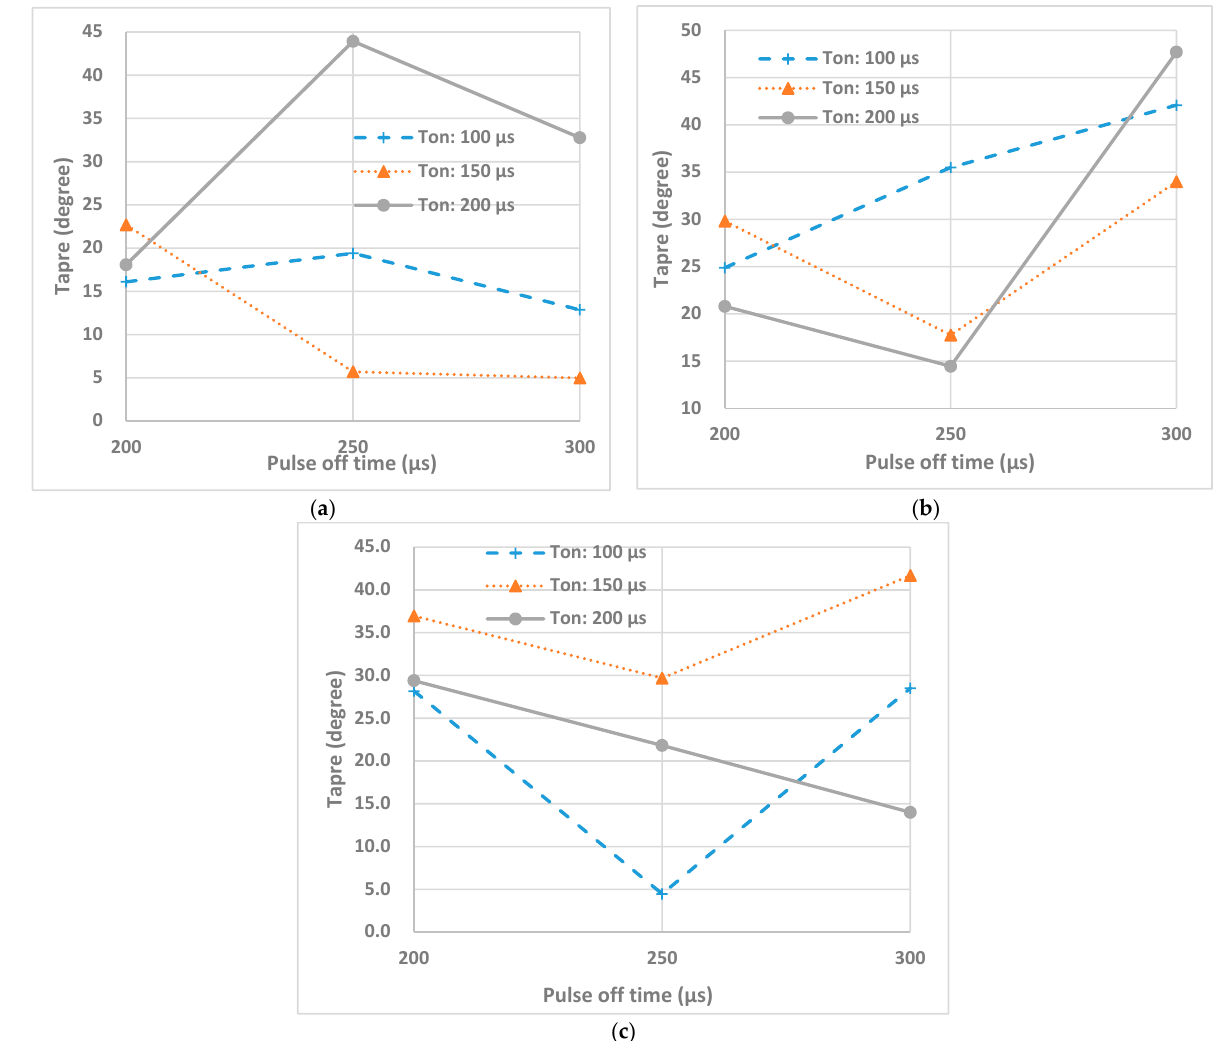
Figure 13. Effects of T on and T off on taper at peak currents ( a ) 1 A, ( b ) 3 A, ( c ) 5 A.